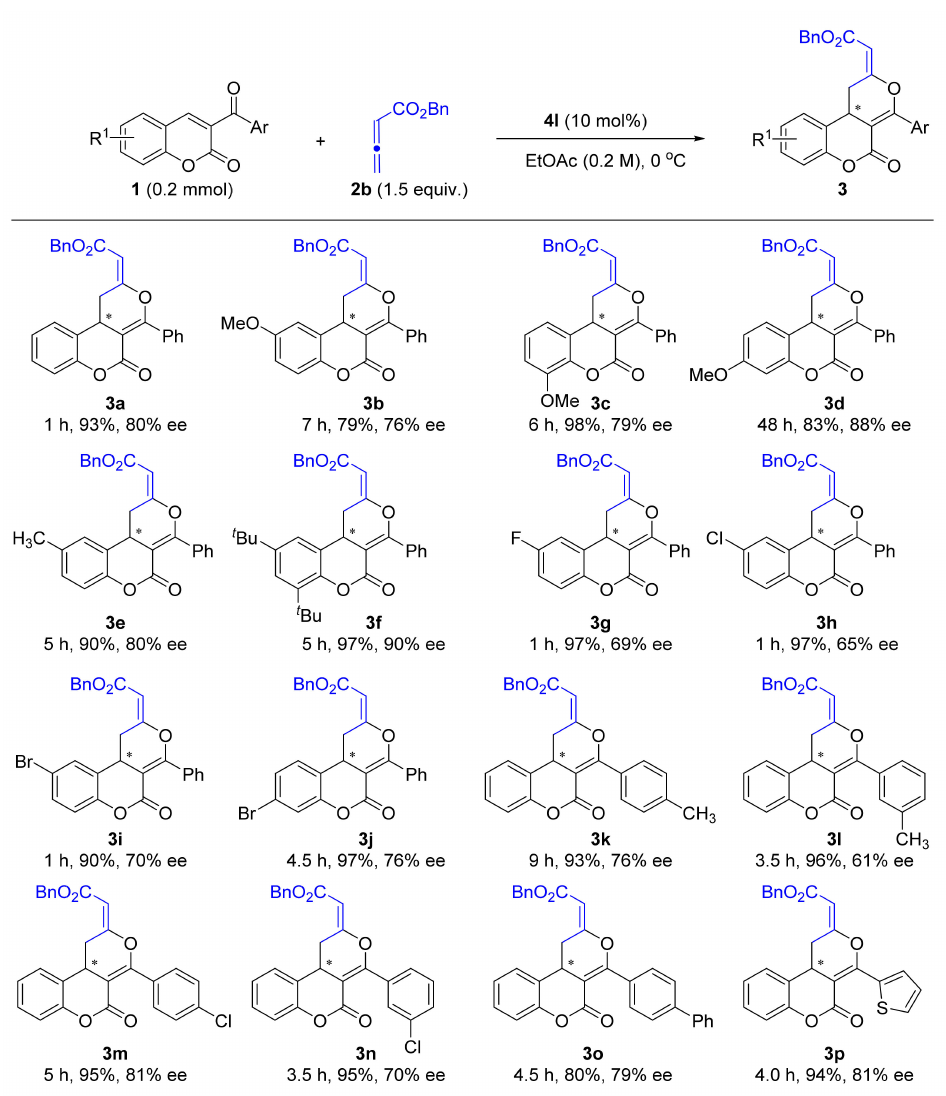
Figure 2. Substrate scope of tertiary amine catalyzed asymmetric [4 + 2] cyclization.